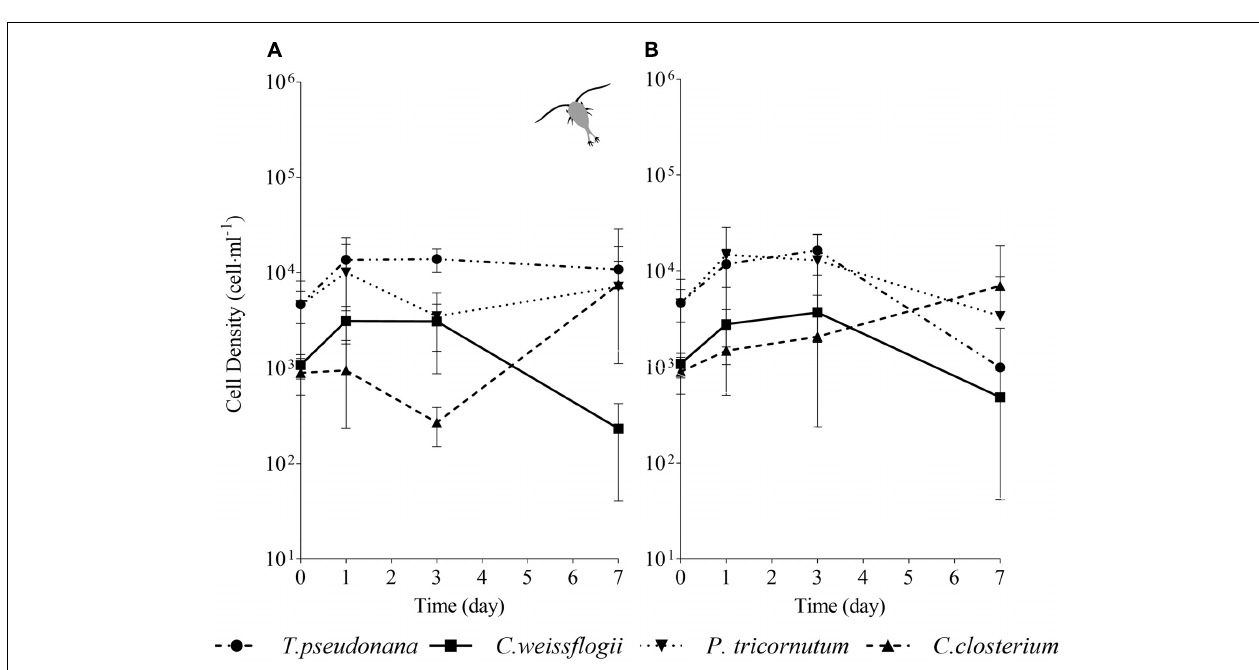
FIGURE 7 | Comparison between growth curves of the diatom mix containing all the species exposed (A) or not (B) to copepods. The data are means of 3 biological replicas. Error bars show SD; no significant difference is observed (two-way ANOVA, p <